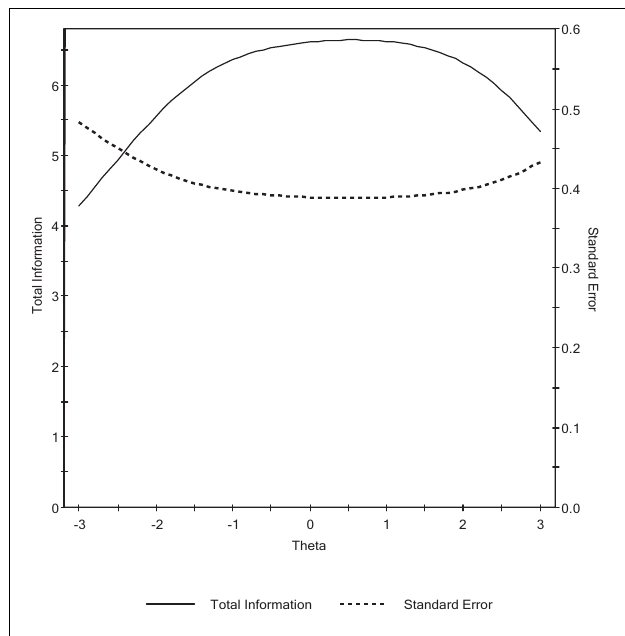
FIGURE 3 | Total information function.